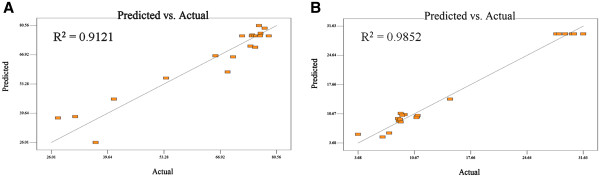
Plot indicating the predicted values against experimental values for cell disruption capability (A) and specific protein release of HBsAg (B). The linear line depicted represents y=x.